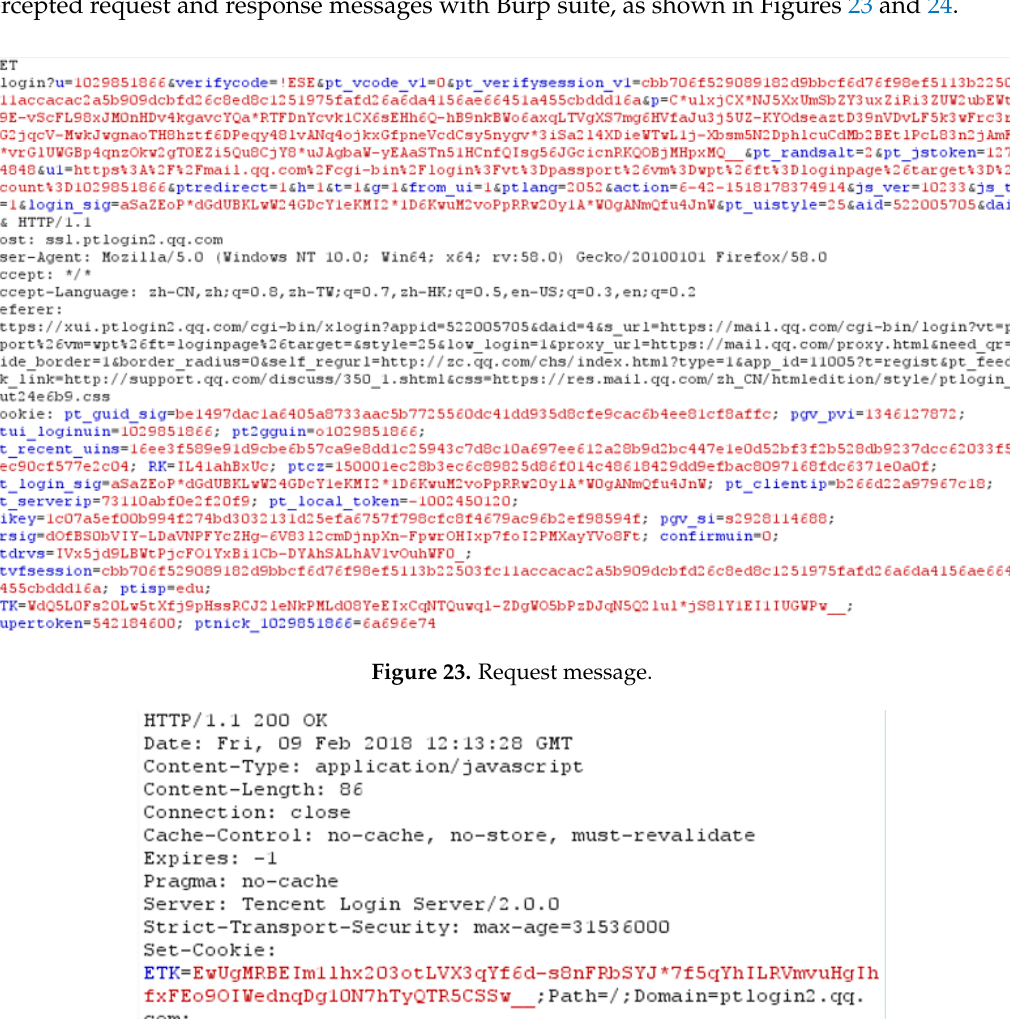
Figure 23. Request message.